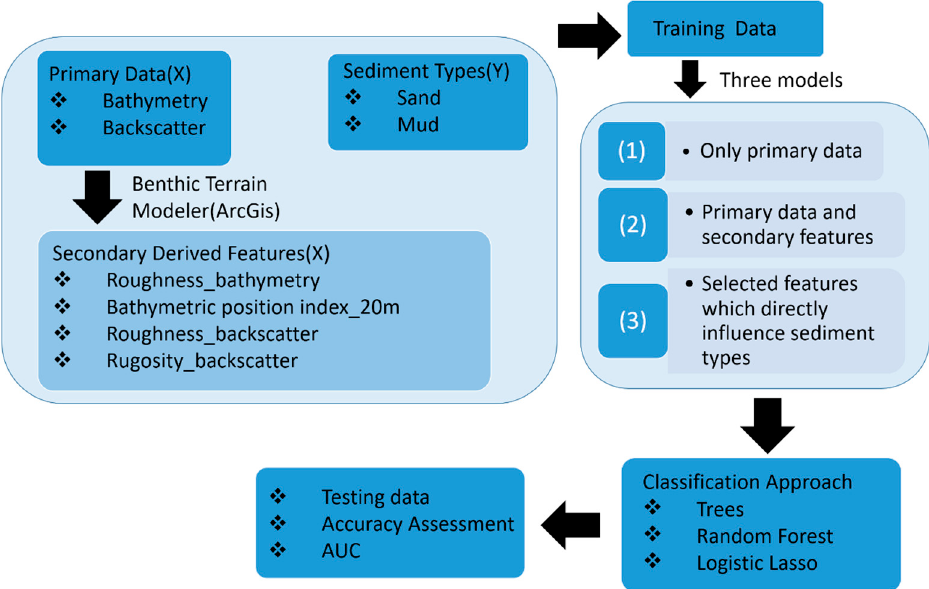
Figure 3. Flowchart of models which covers input features, machine learning (ML) methods, and validation methods.